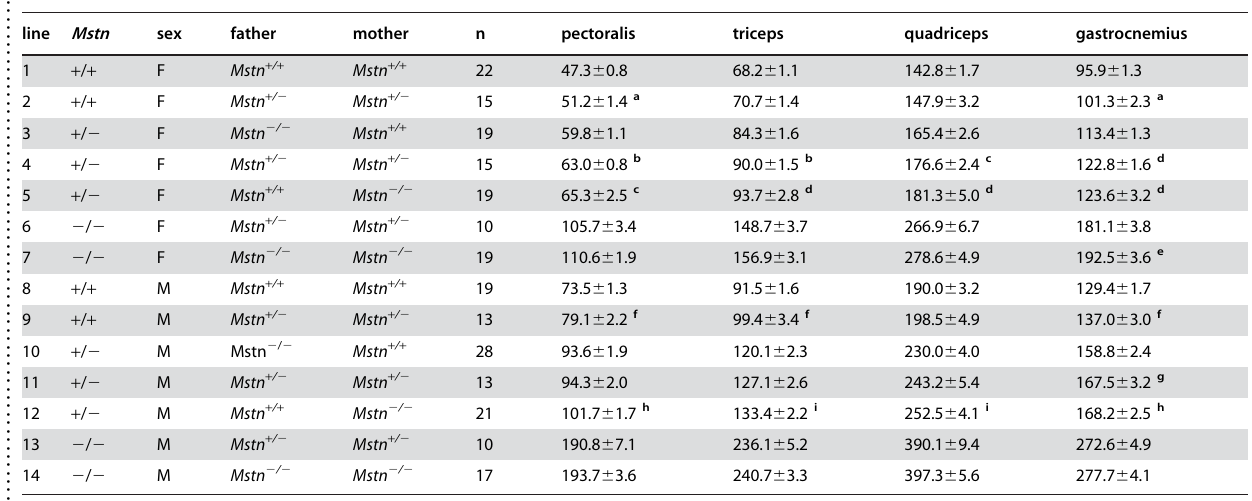
Table 3. Maternal effect of Mstn null mutation. .. ... .... ... ... .... ... ... .... ... ... .... ... ... .... ... ... .... ... ... .... ... ... .... ... ... .... ... ... .... ... ... .... ... ... .... ... ... .... ... ... .... ... ... .